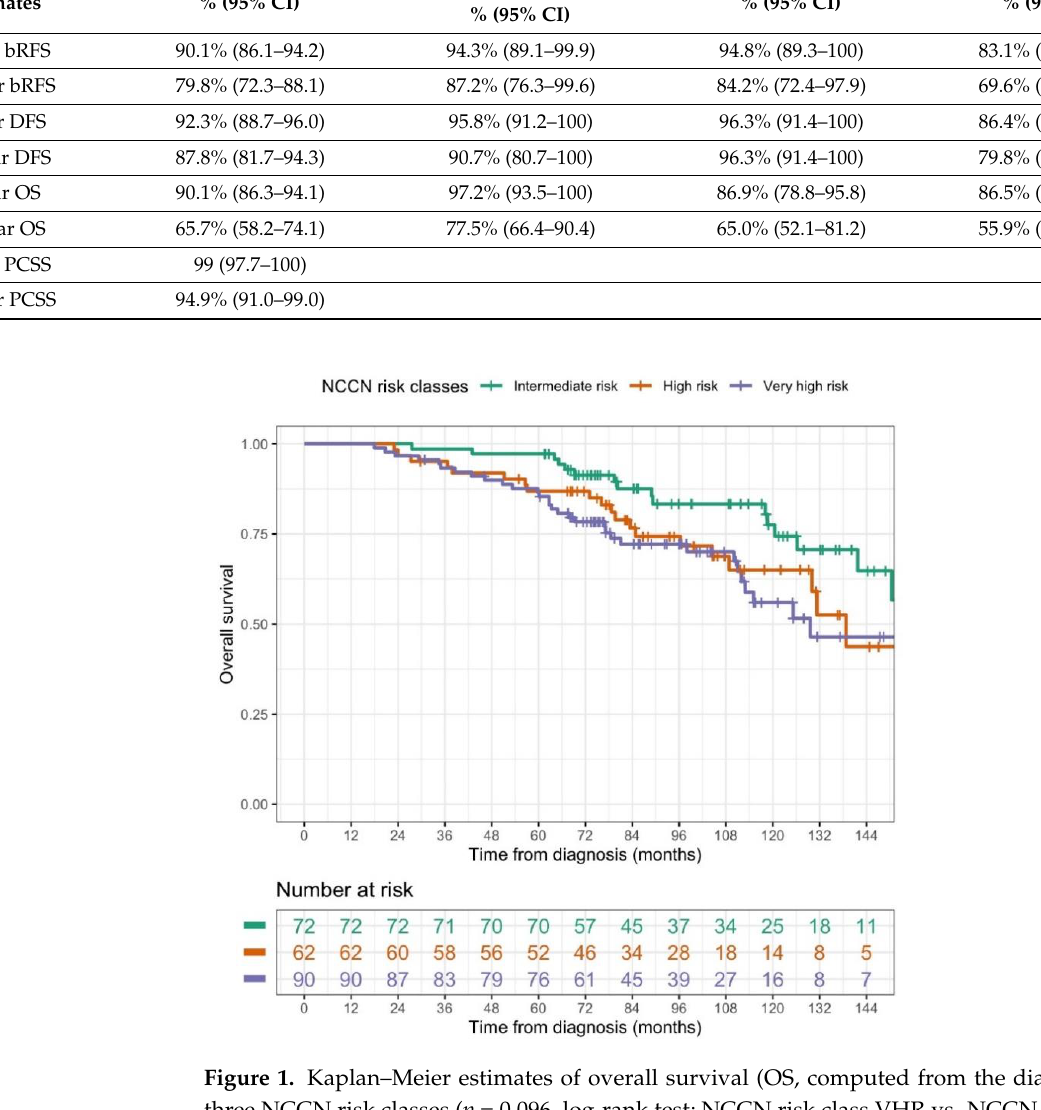
Figure 2. Kaplan–Meier estimates for biochemical relapse-free survival (bRFS) in the three NCCN risk classes ( p = 0.021, log-rank test; NCCN risk class VHR vs. NCCN risk class UIR, HR = 2.7924,